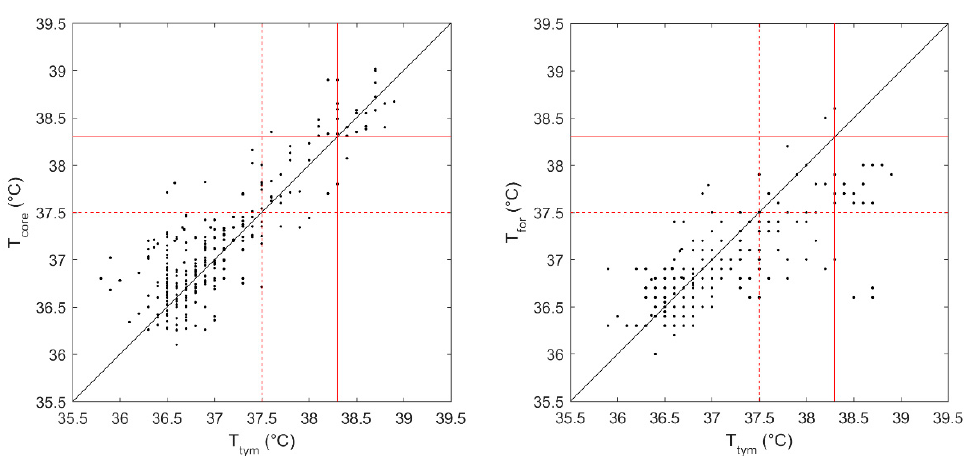
Figure 1. The estimated core temperature (Tcore) ( left panel ) and the forehead temperature (Tfor) ( right panel ) are plotted against the tympanic temperature (Ttym) for each measurement. The red dotted line at a cut-off temperature of 37.5 °C indicates the presence or absence of “hyperthermia”, while the red line at a cut-off value of 38.3 °C indicates the presence of “fever”. The black line suggests the identity with Ttym.